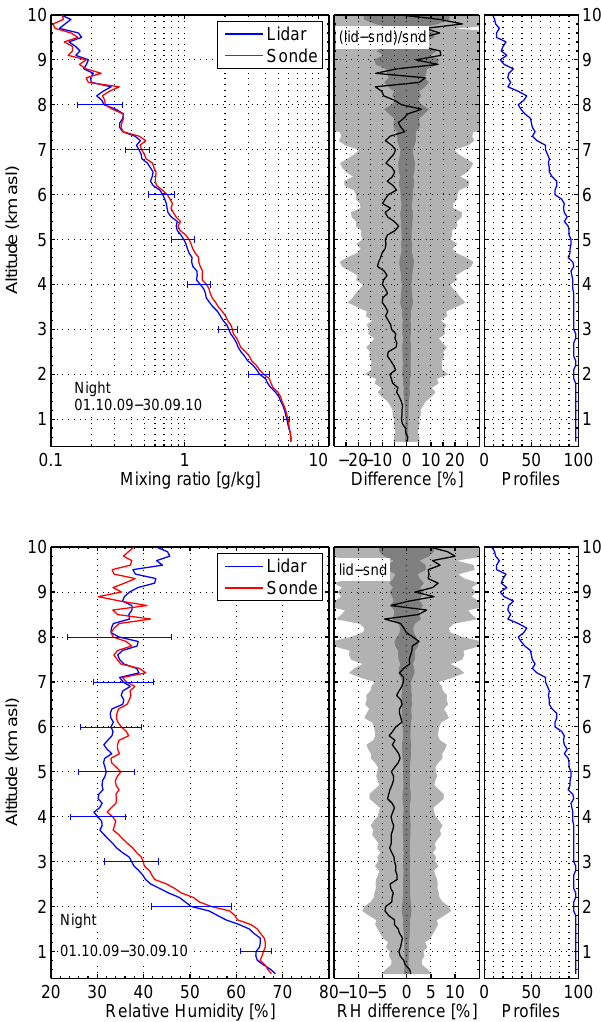
Fig. 7. Top: mean water vapor mixing ratio (left) and mean bias profile (middle) during night. Bottom: mean relative humidity with respect to water (left) and bias profile (middle) during night. Right: number of available profiles n . Middle panels: mean value (solid black), standard deviation σ (light grey), error of the mean value ( σ/ √ n , dark grey). Only clear-sky days are considered.